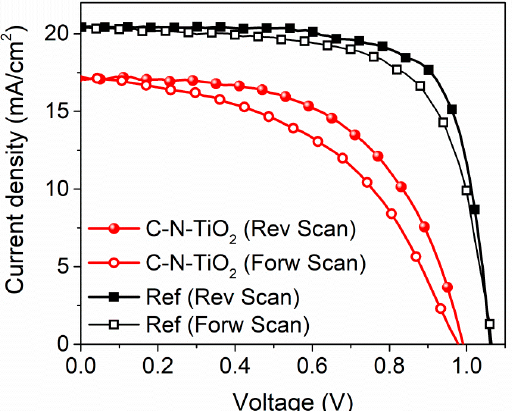
Figure 11. Current density–voltage characteristics for both the best performing reference (standard mTiO 2 ) and C-N-TiO 2 -based devices under 1SUN (1000 W/m 2 ) irradiation in forward and reverse scan directions. Table 6. Averaged (Av.) electrical parameter values and standard deviation calculated over six devices.